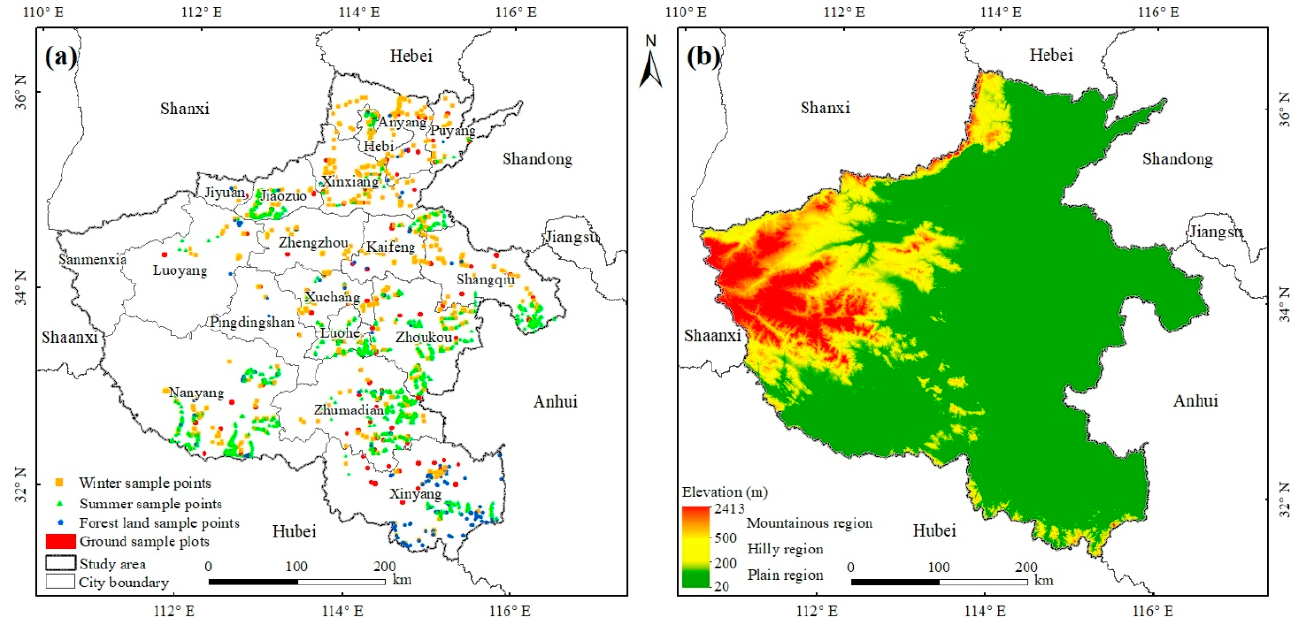
Figure 1. Location of Henan Province and the ground samples in study area with a Universal Transverse Mercator (UTM) projection. Forest land sample points including the sample points of forest-land in summer and winter ( a ). Distribution range of different terrain. The lowest and highest elevation is 20 m and 2413 m, respectively ( b ).